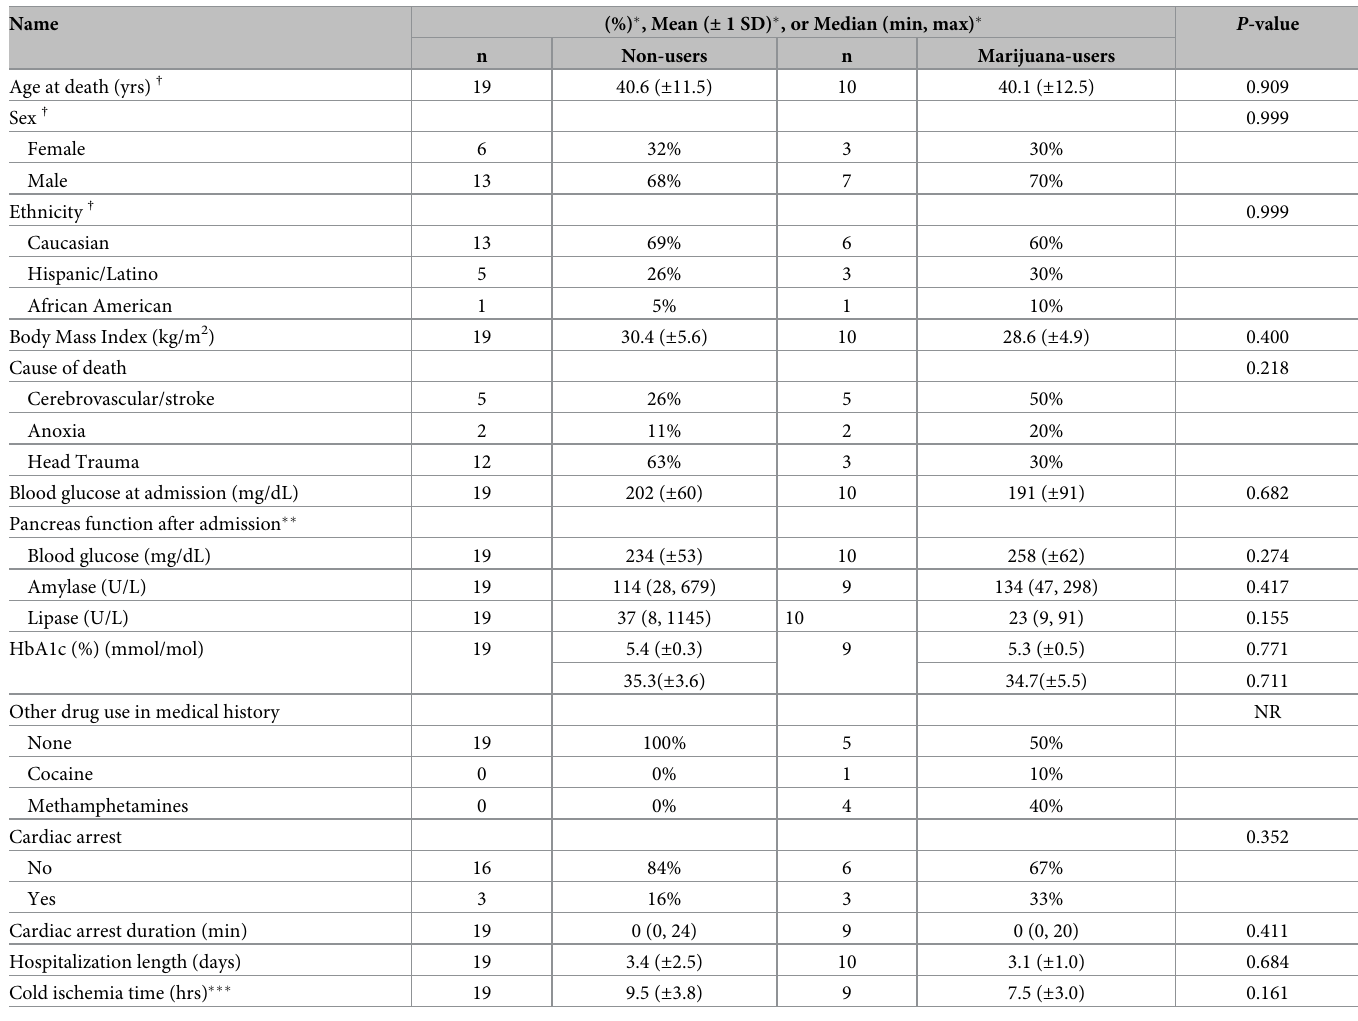
Table 1. Clinical characteristics of organ